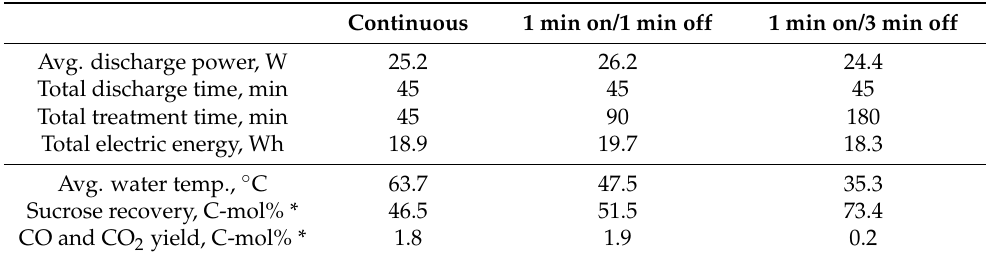
Table 3. Summary of the experimental conditions, sucrose recovery, and gas yield (the sum of CO and CO 2 ) for solution-plasma treatment of sucrose (sucrose concentration, 10 g/L; electrode distance, 1.2 mm; cooled with room-temperature water) with continuous and intermittent discharge. Continuous 1 min on/1 min